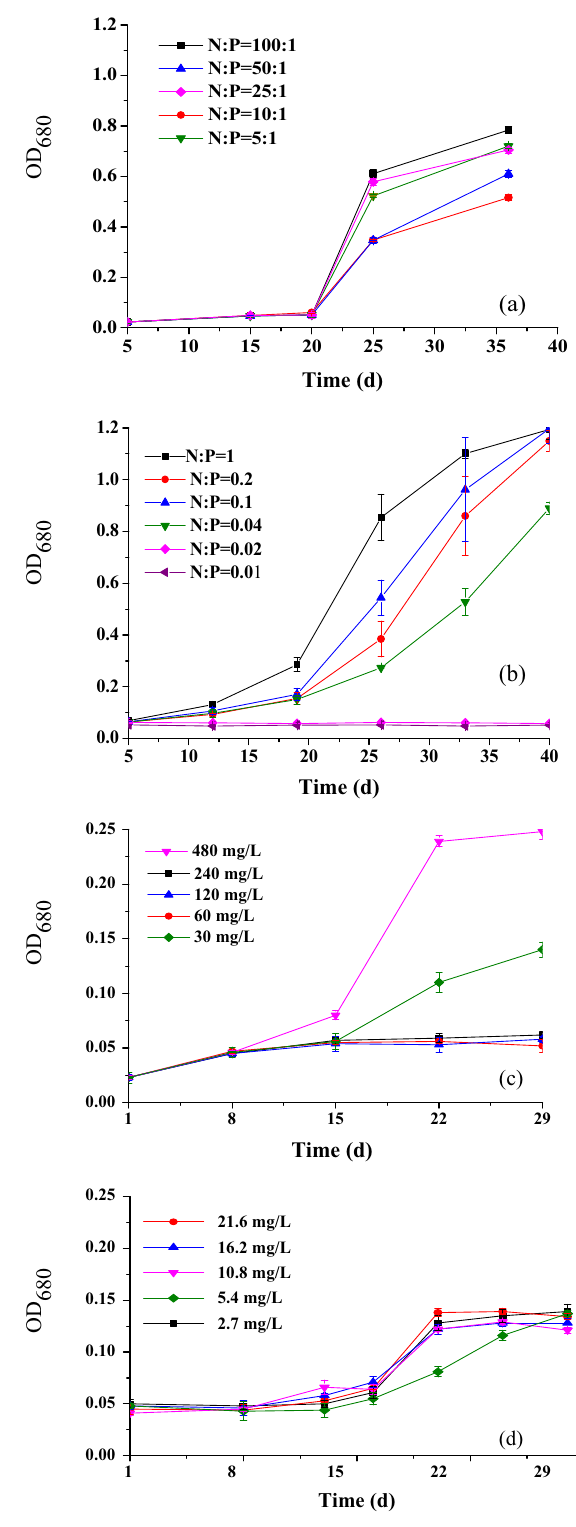
Figure 1: ( a ) The growth of M. aeruginosa cultured under constant P and varying N, ( b ) constant N and varying P, ( c ) di ff erent N con - centrations without P, and ( d ) di ff erent P concentrations without